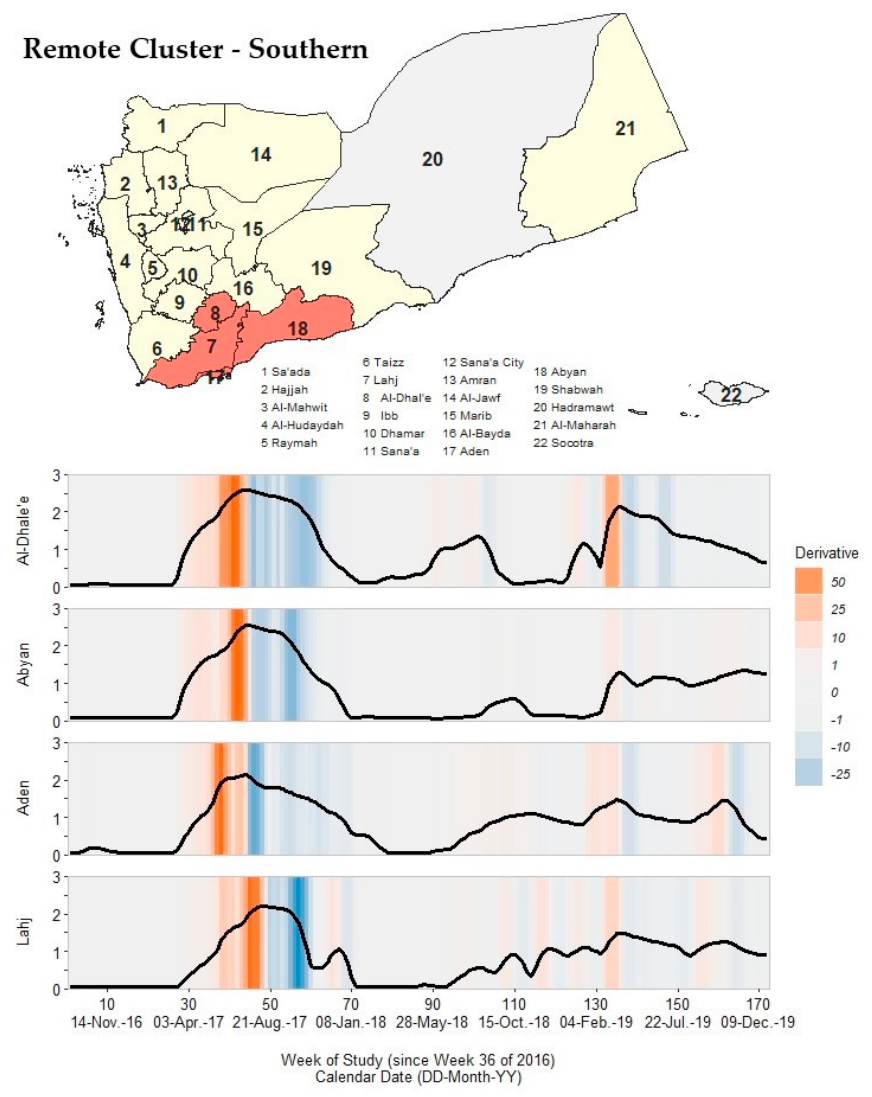
Figure 8. A map of Yemen with a shaded outbreak cluster including Al-Dhale’e, Abyan, Aden, and Lahj, and a stacked time series plot and heatmap for each governorate’s outbreak signature. Top panel: the governorate-level map indicates governorates within the cluster in orange, remaining governorates within our study in yellow, and excluded governorates in grey (the Hadramaut and Socotra island governorate). Bottom panel: stacked time series plots for each governorate within the cluster. All plots show log10-transformed smoothed rates produced using Kolmogorov–Zurbenko adaptive filters from Week 36 (4–11 September) of 2016 through Week 52 (23–29 December) of 2019. Smoothed rates (laboratory-confirmed cholera cases per 100,000 persons) were estimated using the best performing smoother. Backgrounds for each plot are heatmaps of trivial derivative values, ranging from − 25 (dark blue) to +50 (dark orange) with values near zero in grey. Time series plots have a common horizontal axis of time reported in weeks since Week 36 of 2016 (defined as study Week 0). All rates and trivial derivates were calculated for the 172 weeks of time series. Data used to develop this visualization are reported in Table 1 and Supplementary Excel Table